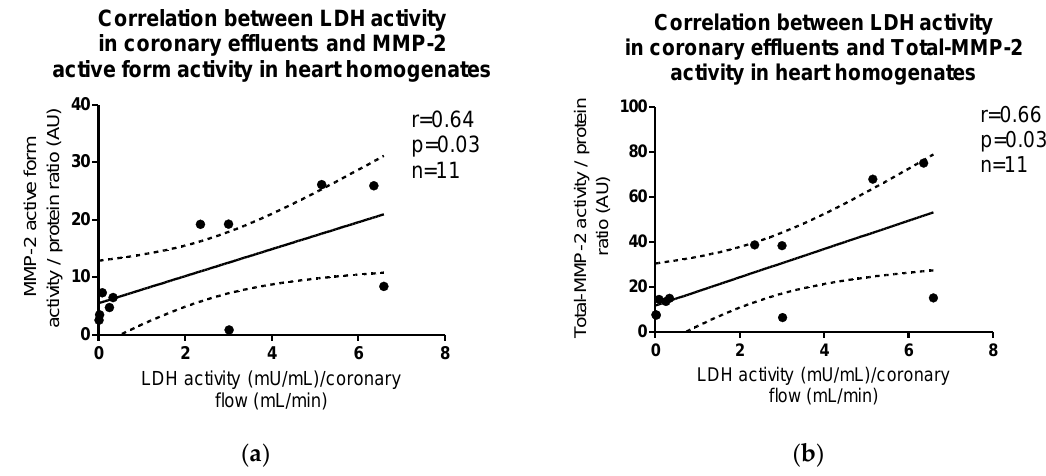
Figure 5. Correlations between LDH activity in coronary effluents and ( a ) MMP-2 active form, ( b ) Total-MMP-2 activity in myocytes.